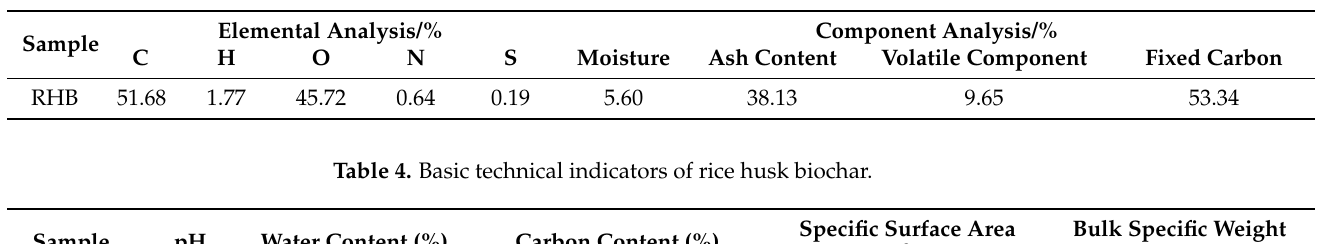
Table 3. Component analysis of rice husk biochar.